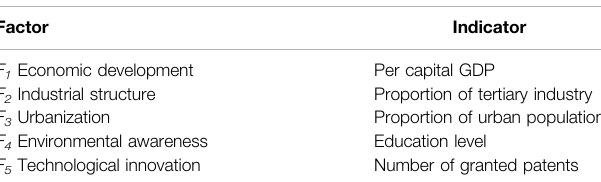
TABLE3| FactorsaffectingthecouplingcoordinationrelationshipsofNRUBsand indicators. Factor